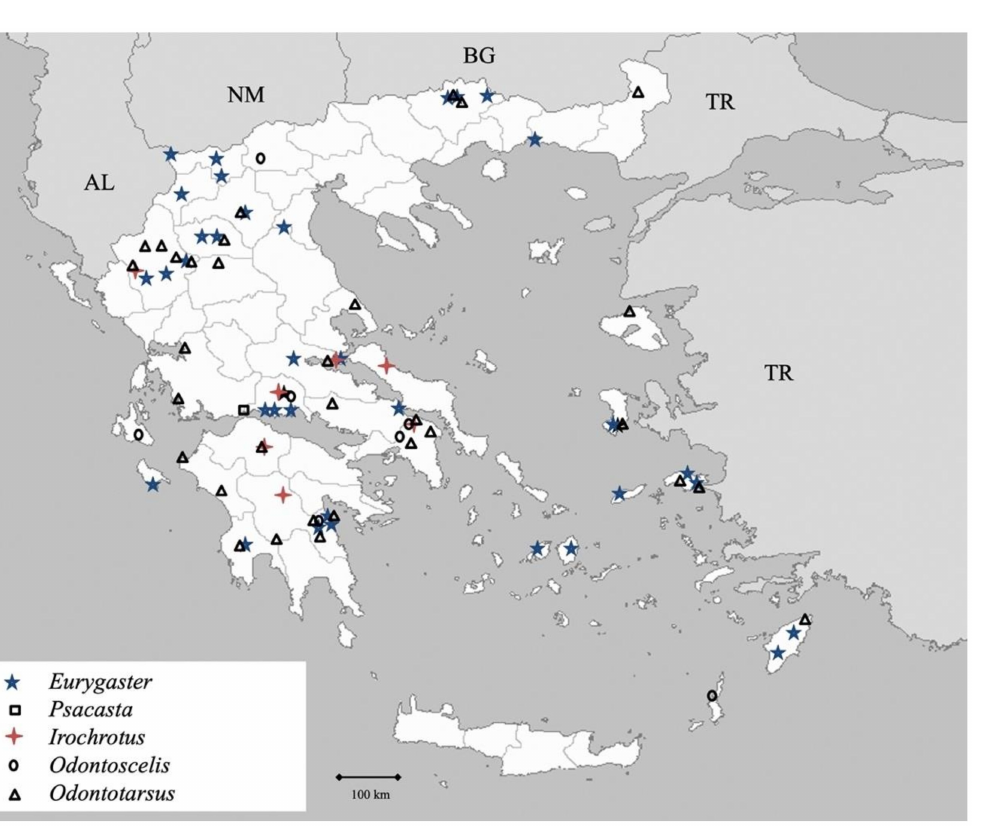
Figure 22. Map showing collecting sites of species of genera Eurygaster, Psacasta, Irochrotus, Odon- toscelis and Odontotarsus during the present study in